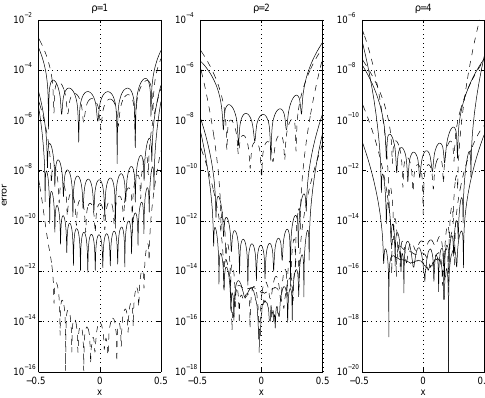
Figure 18. Errors for the Gegenbauer reconstruction of the function f ( x ) defined by (6.1) for ρ = 1 , 2 , and 4 and m = 6 , 12 , and 18 , with parameters α opt,I , N opt,I (solid lines) and α opt,ρ , N opt,ρ (dashed lines). These parameters are listed in Table 1 and Table 2.